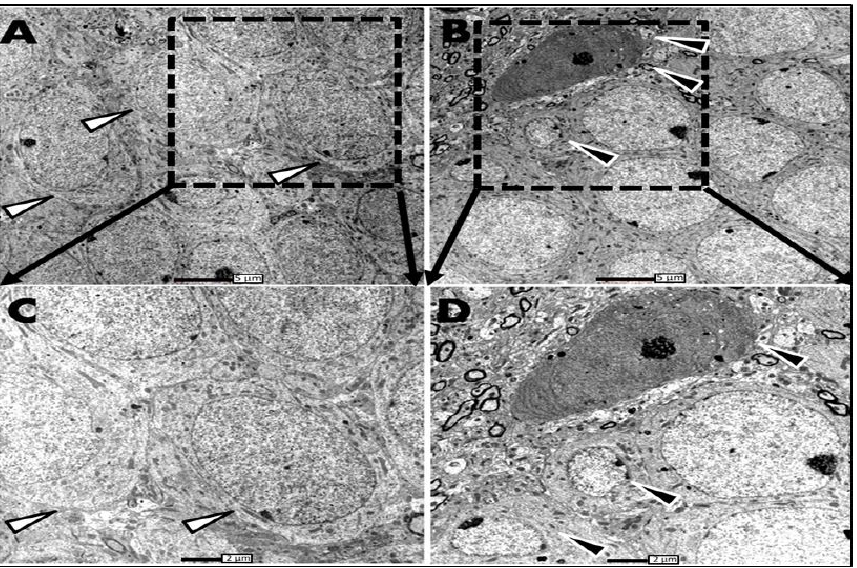
nucleus is surrounded by a thin layer of cytoplasm (white arrows). ( B ) in the ADX rats a few degen-